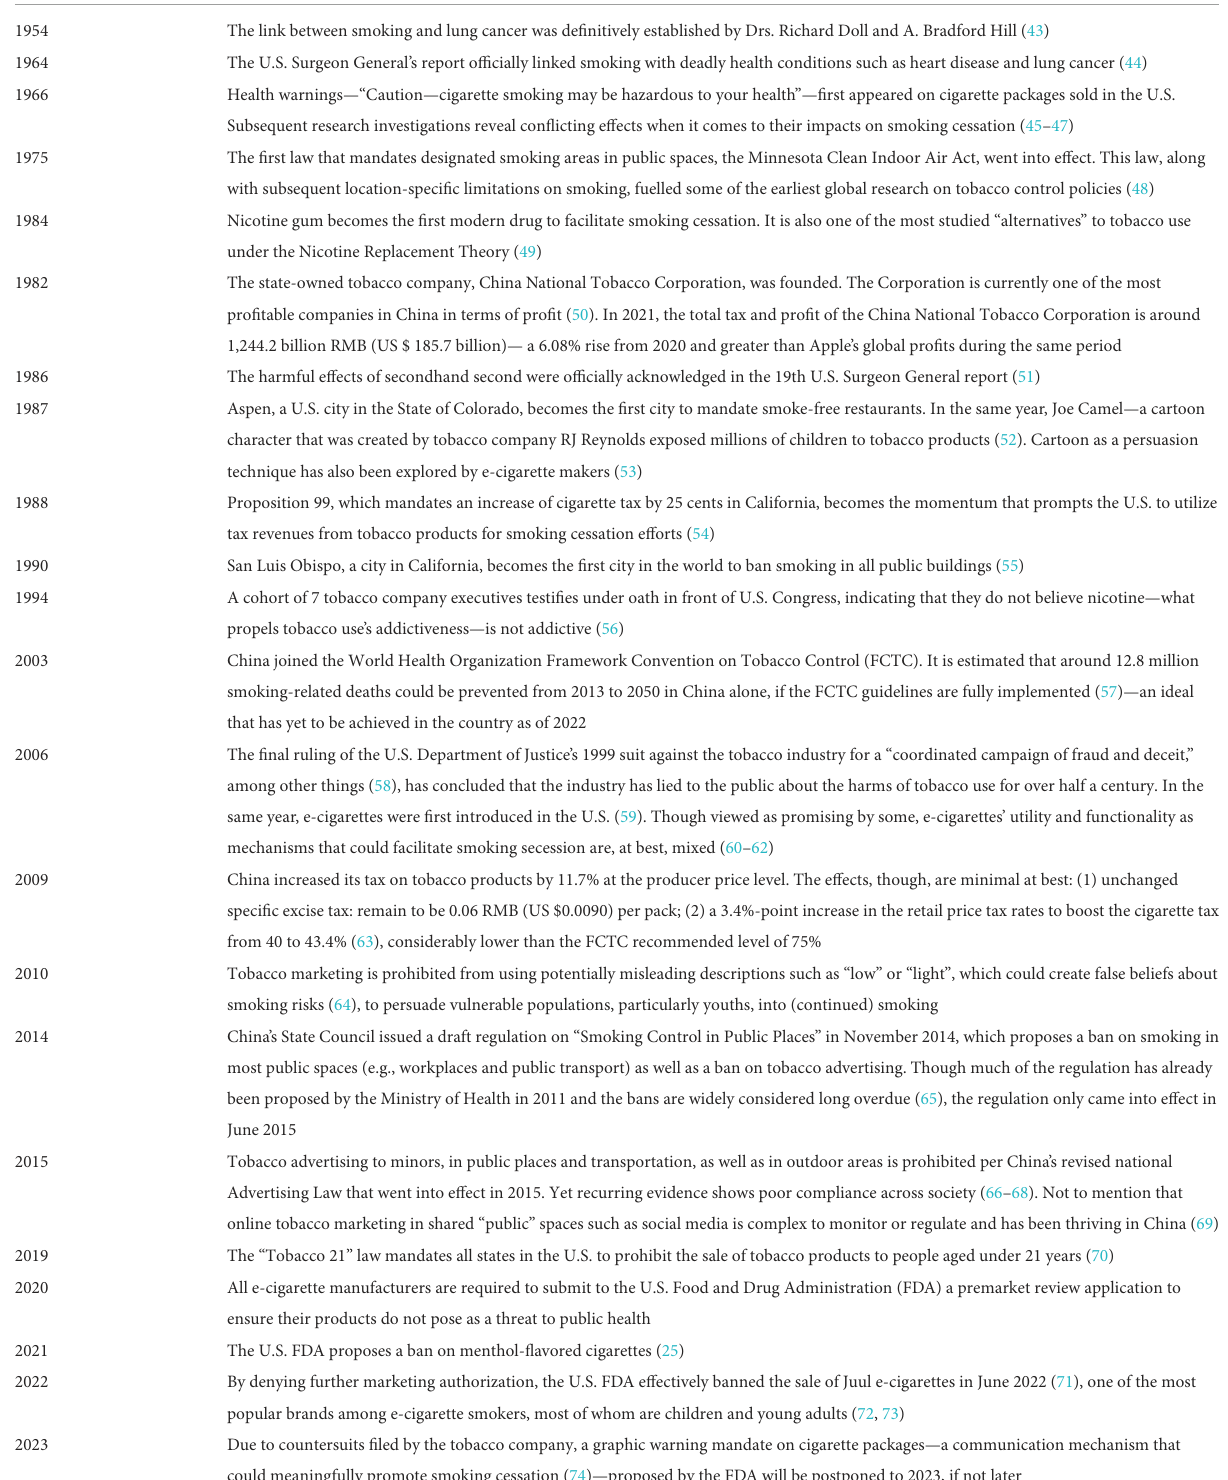
TABLE 1 Historical timeline: Key factors that shape tobacco use in the U.S. and China. Year Key factors that shape tobacco use in the U.S. and China